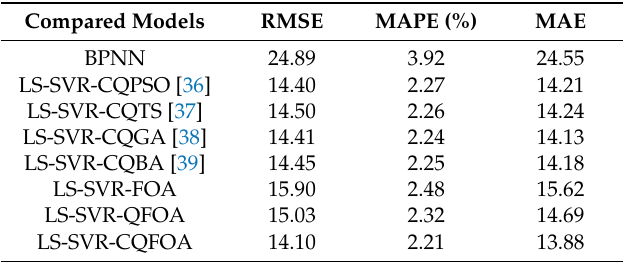
Table 7. Forecasting indexes of LS-SVR-CQFOA and other models for IDAS 2014. Compared Models